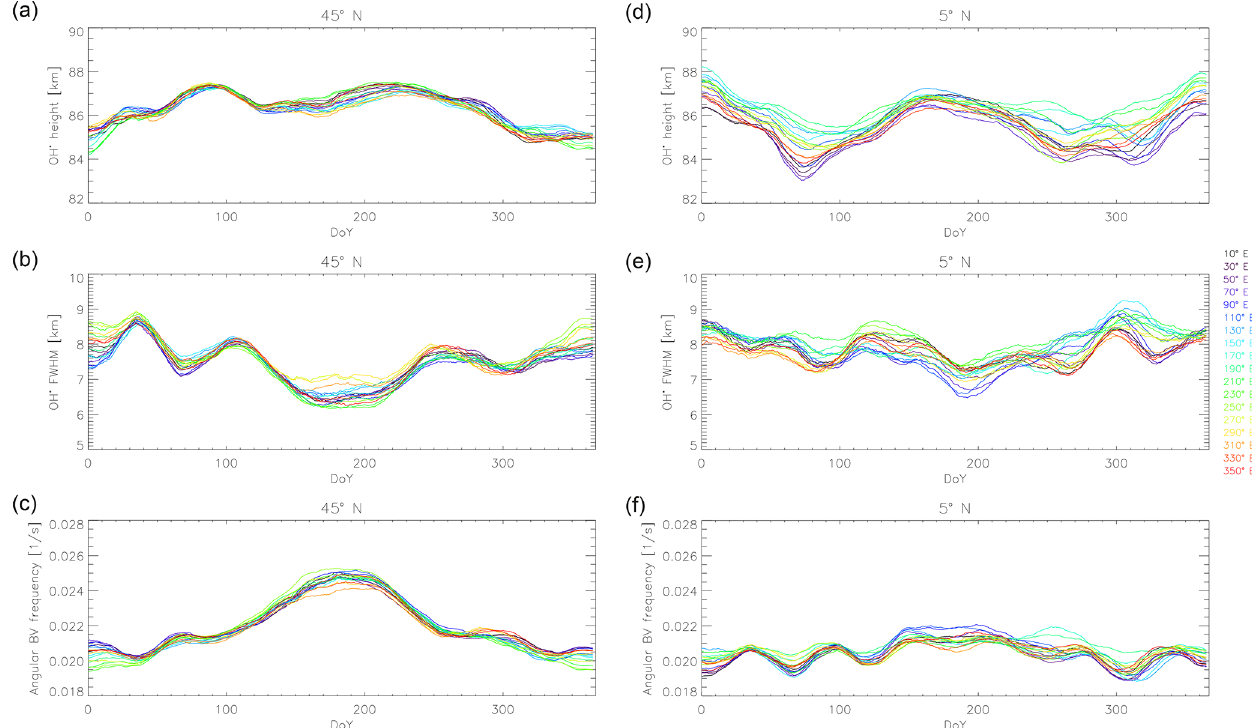
Figure 1. OH ∗ -layer height (a, d) , FWHM (b, e) and OH ∗ -equivalent BV frequency (c, f) are shown for the latitudinal band of 45 ± 5 ◦ N (a– c) and 5 ± 5 ◦ N (d–f) depending on longitudinal bands (longitude ± 10 ◦ , colour coded) and DoY. The data are averaged for each DoY. Additionally, they are subject to a 31-point sliding mean. In order to facilitate comparison, the scales of the plots referring to 45 ± 5 ◦ N and 5 ± 5 ◦ N are